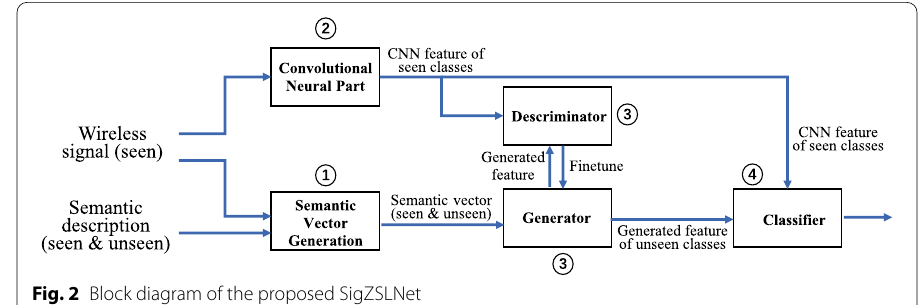
Fig. 2 Block diagram of the proposed